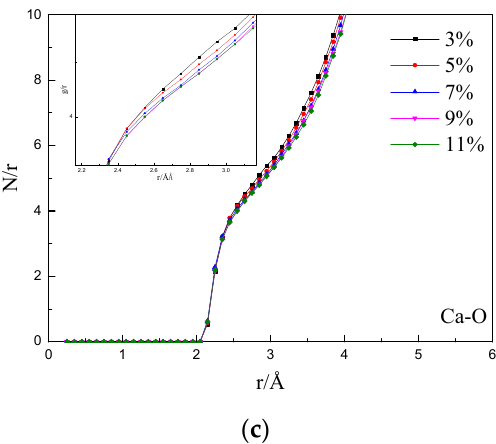
Figure 9. Coordination number function of ( a ) Si–O ( b ) Al–O and ( c ) Ca–O at different CaF 2 contents.